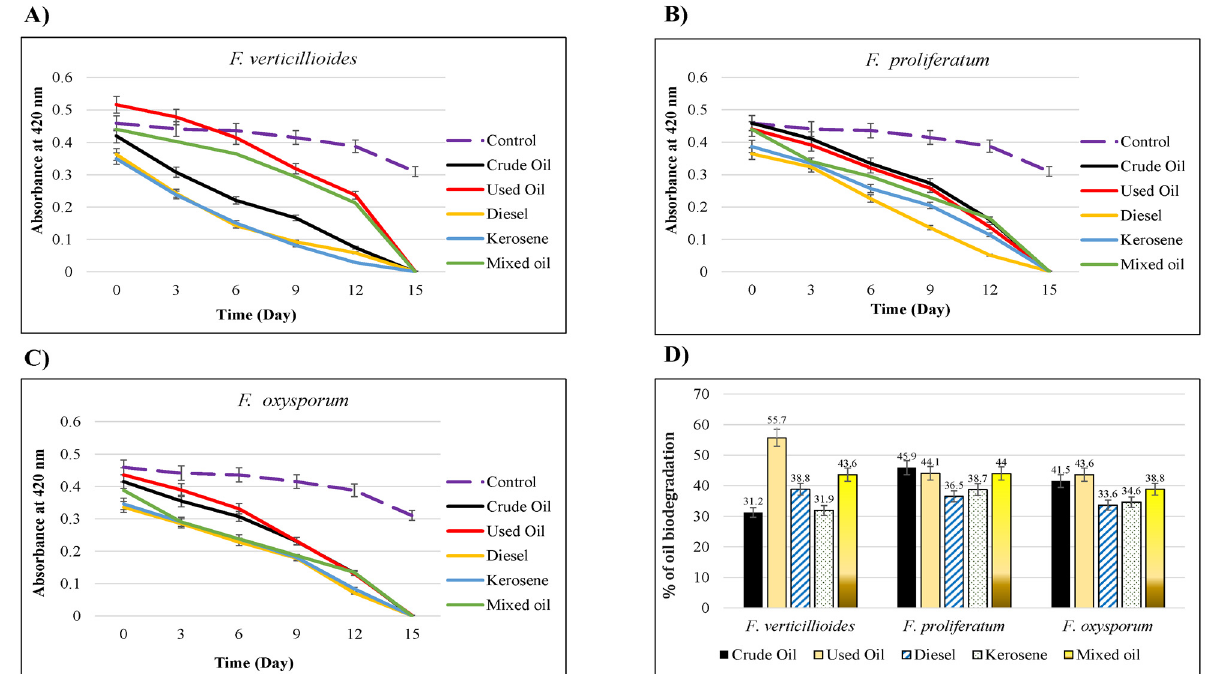
Figure 7. The oil biodegrading ability of tested isolates against different carbon sources by DCPIP assay. DCPIP technique was employed to assess the oil-degrading ability of fungal isolates [36–38]. MSM media supplemented with 1% of each hydrocarbon was mixed with 0.1% Tween 80 and 0.6 mg/mL DCPIP, then 1 cm 2 of the fungal hyphae were added and incubated for two weeks. DCPIP results was obtained by measuring the colorimetric change, at 420 nm of different hydrocarbons with or without the fungal species for 15 days. ( A ) F. verticillioides , ( B ) F. proliferatum , ( C ) F. oxysporum , ( D ) Comparison of oil biodegradation percentage of all isolates at the 15th day post-incubation.